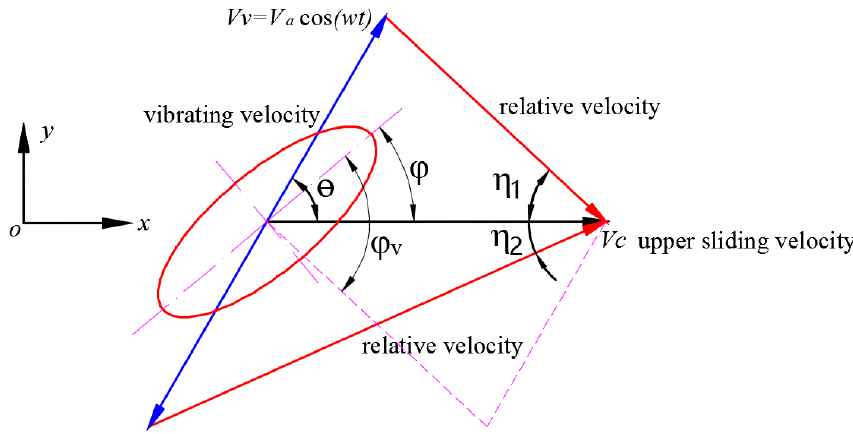
Figure 4. The direction of in-plane vibration and its effect on orientation angle.